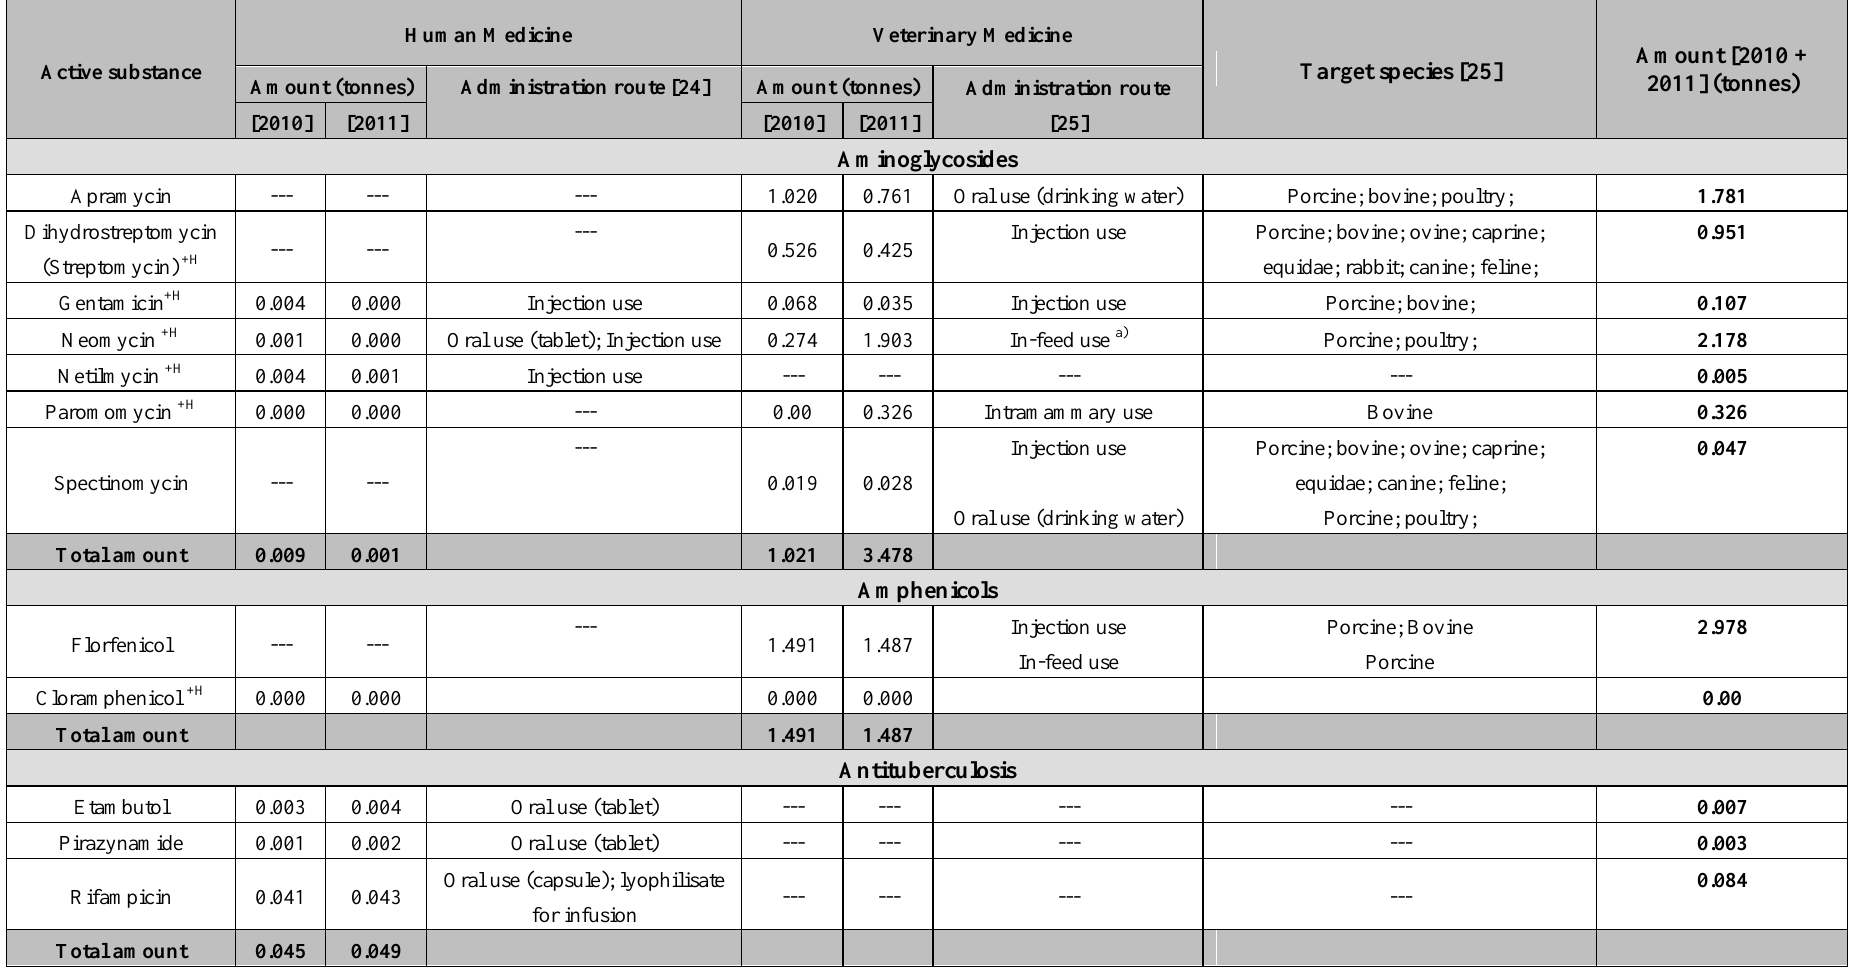
Table 1. Estimation of antibiotic consumption in the human primary health care sector and in veterinary practice by route of administration and target species in the period of